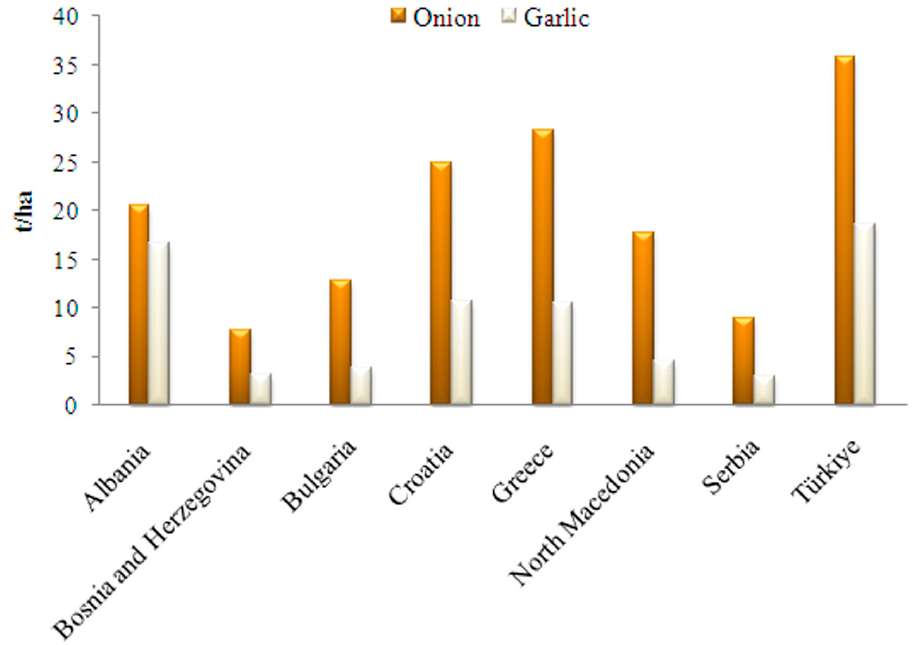
Figure 4. Average annual yield (tons per hectare) of onion and garlic in the Balkan region countries (according to FAOStat 2021 [8]).